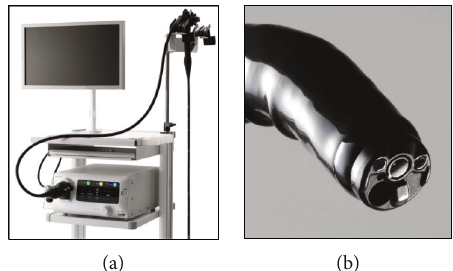
Figure 1: A compact light-processor combined LED endoscopic system and a dedicated LED endoscope. (a). A compact light-processor combined LED endoscopic system (EP-6000, Fuji fi lm Co.) and LED endoscope (6000 series; Fuji fi lm Co.). (b). The diameter of the LED endoscope (EC-6600ZP) is 11.7mm, and the diameter of the working channel is 3.2mm.